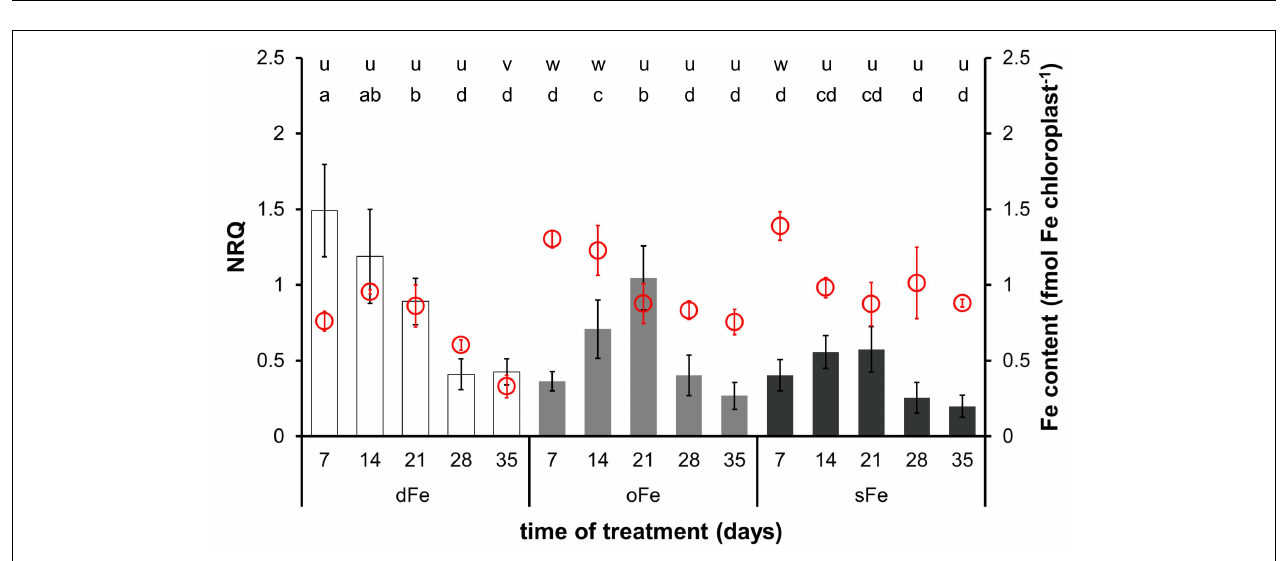
FIGURE 4 | Expression of BnFRO7 (bar graph, left scale) and Fe content of chloroplasts (scatter plot in red, right scale) in the 4th leaves of plants grown on deficient (dFe), optimal (oFe) and supraoptimal (sFe) Fe supply, represented by open, light grey and dark grey columns, respectively. Error bars represent SD values. To compare differences between times of measurements, one-way ANOVAs were performed with Tukey–Kramer multiple comparison post hoc test (expression: P < 0.05, n = 12; Fe content: P < 0.05, n = 9), indicated by letters (NRQ: a–e; Fe content: u–w).